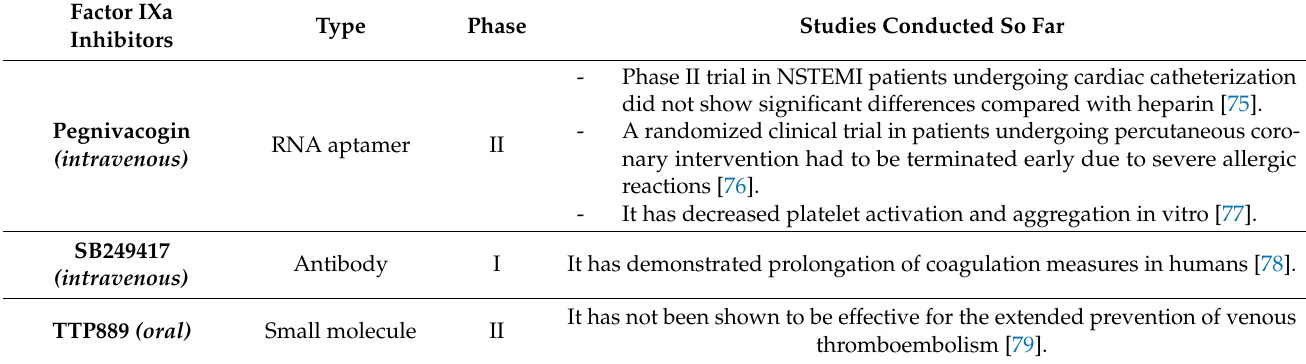
Table 4. Factor IXa inhibitors currently under development. This table includes the emerging FIXa inhibitors and details the studies conducted so far to assess their efficacy and